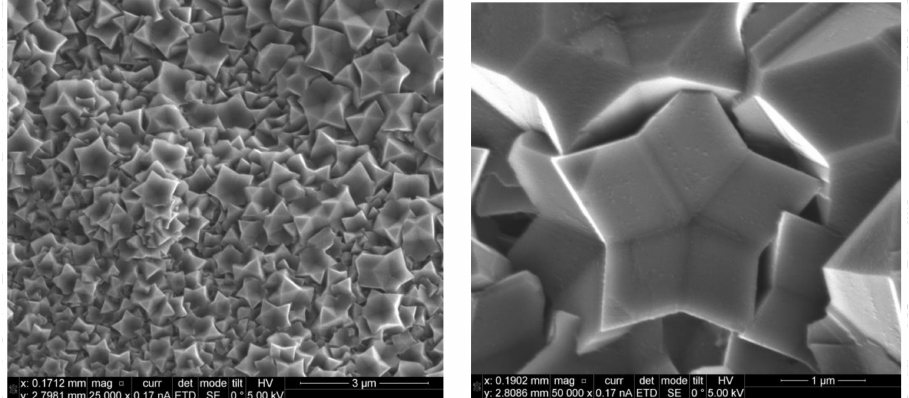
Figure 1. Scanning electron microscope (SEM) images of star-shaped pentagonal boron carbide microcrystals taken at different